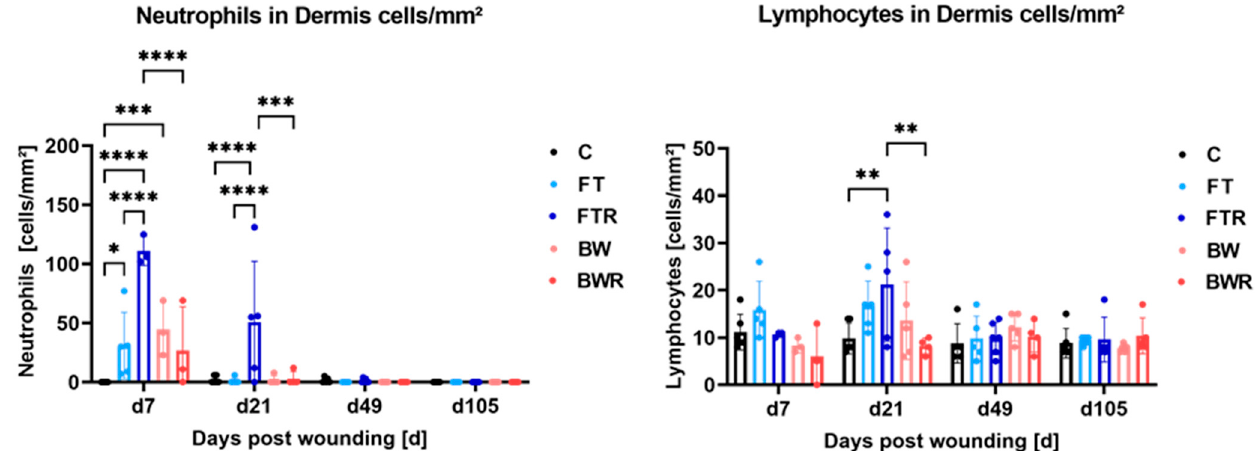
Figure 4. Resiquimod-induced inflammation and burn injury increased infiltration of neutrophils